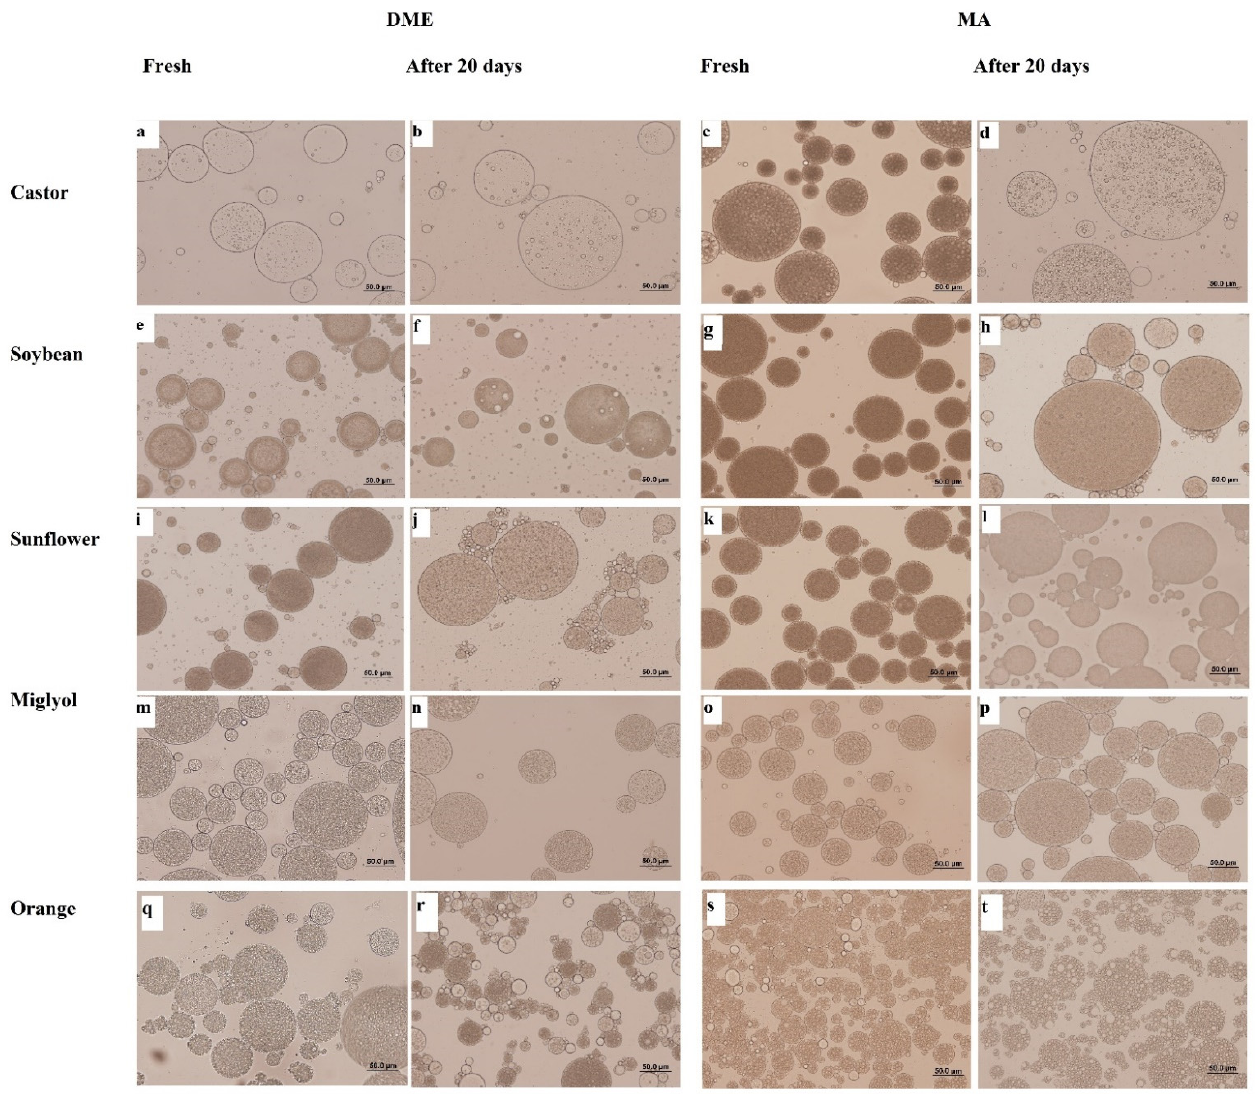
Figure 3. Optical microscopy images of fresh DEs prepared by membrane emulsification ( a , e , i , m , q ), DEs prepared by membrane emulsification after 20 days of storage ( b , f , j , n , r ), fresh DEs prepared by mechanical agitation ( c , g , k , o , s ) and DEs prepared by mechanical agitation after 20 days of storage ( d , h , l , p , t ). All scale bars represent 50 µ